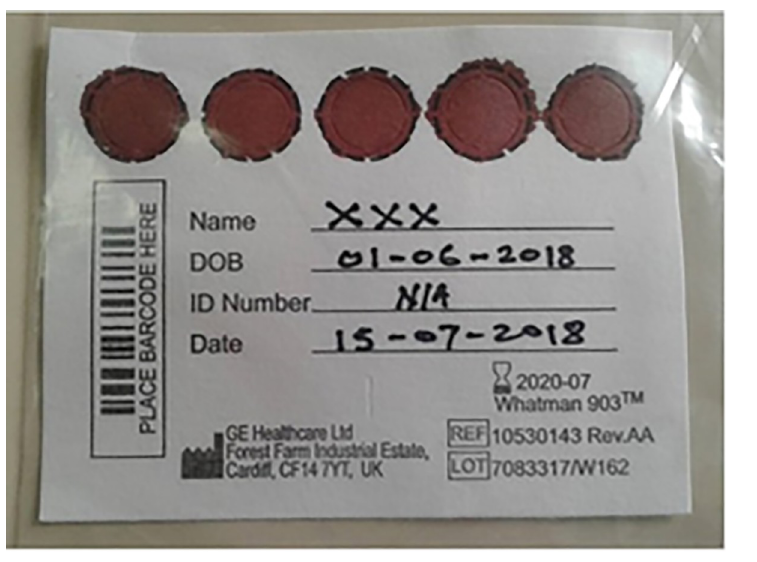
Fig 1. Five circles blood spot